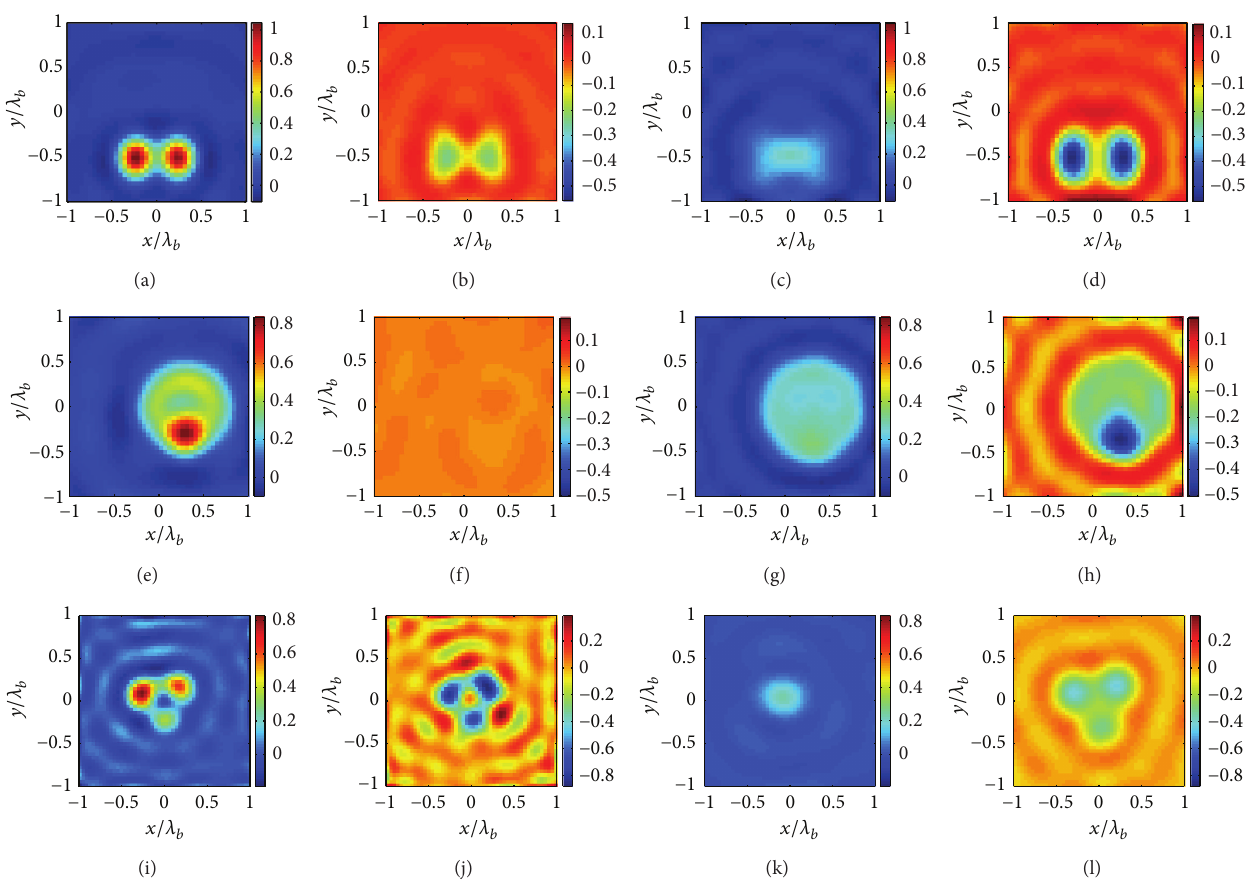
Figure 5: From top to bottom: imaging results for the three examples. From left to right: real and imaginary part of the retrieved contrast profile by means of the proposed approach ( 𝑇 = 65, 𝑇 = 62, and 𝑇 = 132) and the BA ( 𝑇 = 76, 𝑇 = 78, and 𝑇 =